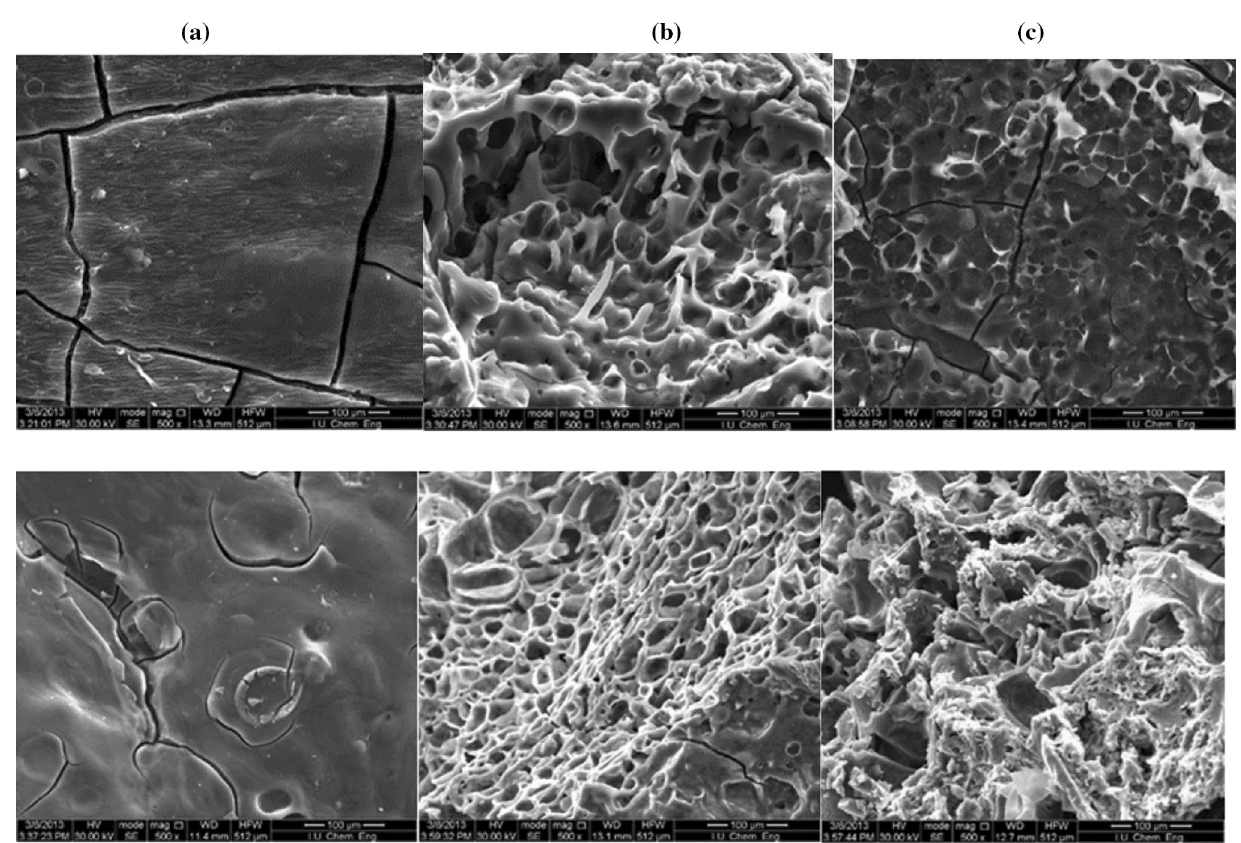
Fig. 7 SEM images of activated carbons from (above) hazelnut shell and (below) orange peel a untreated, b treated with ZnCl with H 3 PO 4 in the concentrations of